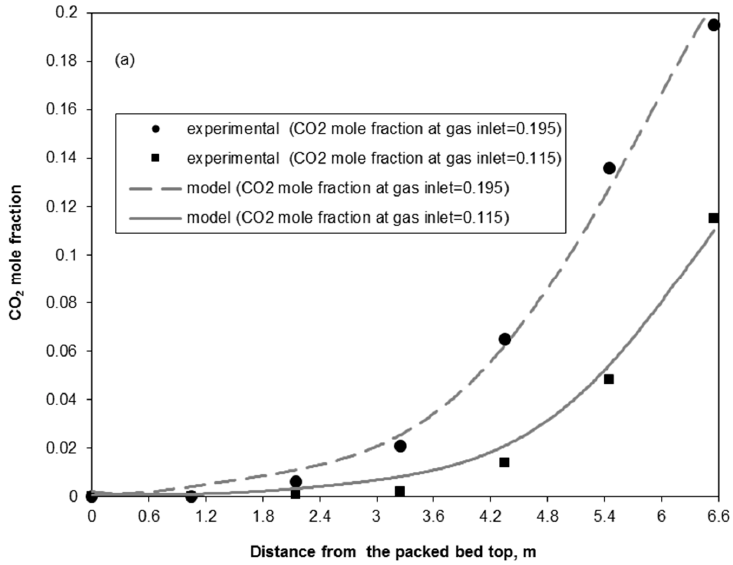
Figure 3. Experimental and theoretical axial CO 2 mole fraction ( a ) and temperature ( b ) profiles for CO 2 -MEA absorption in a countercurrent packed-bed column (D = 0.1 m; H = 6.55 m; CO 2 -2mol/L MEA system; Liquid flow rate = 13.5 m 3 /m 2 h; Gas flow rate = 14.8 mol/m 2 s; T in = 19 °C). Experimental data were taken from Tontiwachwuthikul et al. [49].